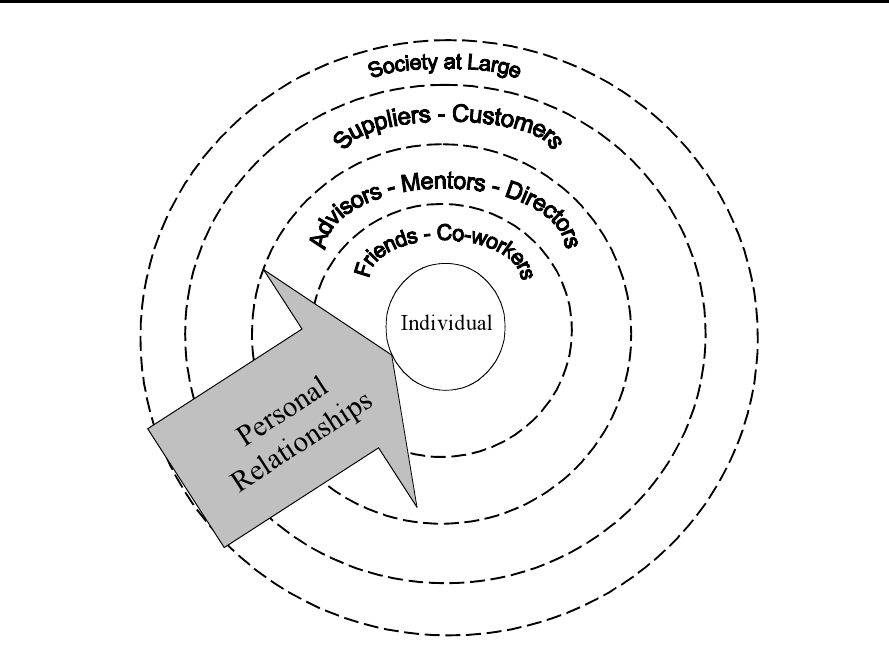
Figure 1. Model of an Entrepreneur’s Social